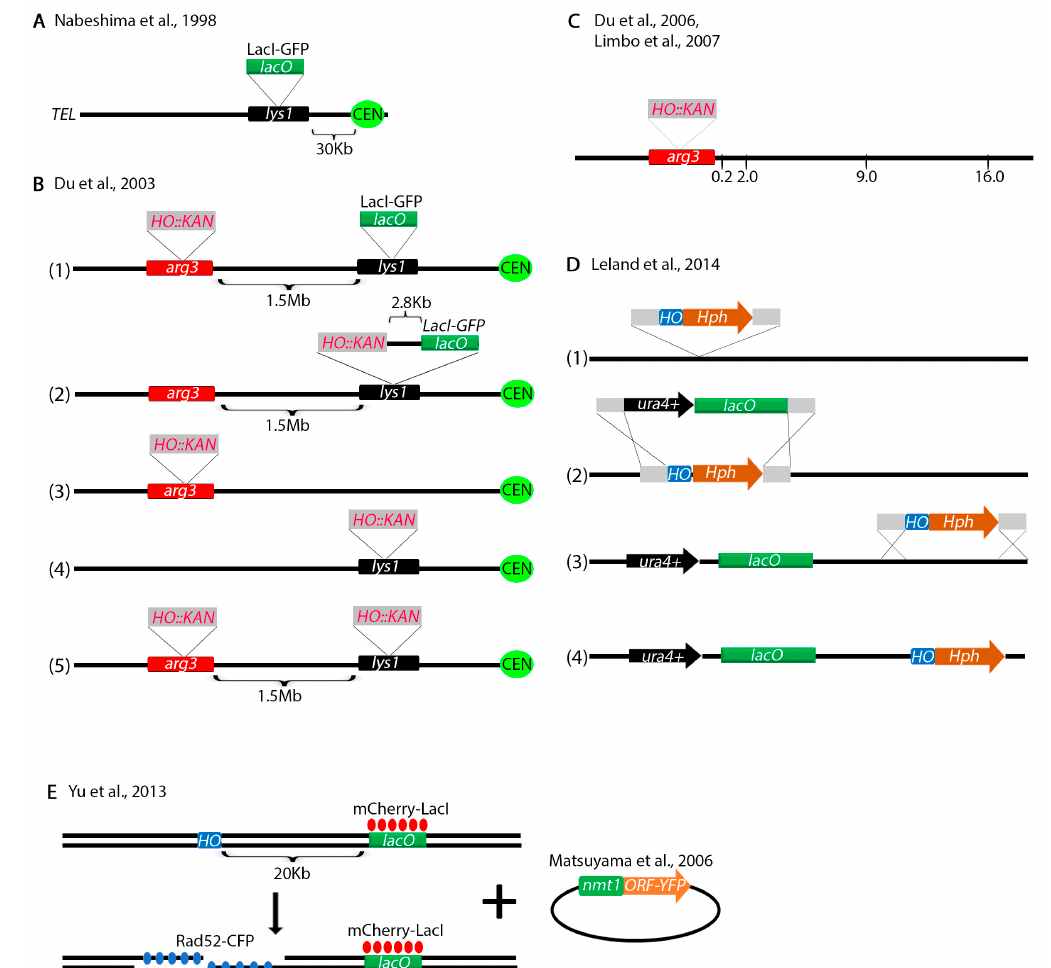
Figure 6. Fluorescence and biochemical assays. ( A ) An assay designed by Nabeshima et al. to study centromere dynamics. A LacO array was placed 30 Kb from the centromere of Ch.I. LacI-GFP binding allows visualization of centromeres. ( B ) Assays developed by Du et al. to study repair of a DSB. (1) The HO endonuclease restriction site marked with KAN was placed 1.5 Mb away from the LacO array at the arg3 + locus. (2) HO::KAN was placed 2.8 Kb from the LacO array. Constructs without a LacO array with the HO restriction site at arg3 + (3), lys1 + (4) or both arg3 + and lys1 + (5) were also engineered. These constructs can be used to study foci of fluorescently tagged DNA damage repair proteins. ( C ) The construct in ( B ) (3) was adapted for Chromatin Immunoprecipitation. PCR primers were engineered at 0.2, 2.0, 9.0 and 16.0 Kb from the break. Upon induction of the break, multiplex PCR can analyze binding of various proteins at all four locations at once. ( D ) An assay to integrate the LacO array and the HO restriction site anywhere in the yeast genome. Please see text for details. ( E ) An assay to study YFP tagged proteins interacting with a DSB. A lacO array that interacts with LacI- mCherry was placed 30 Kb from the HO endonuclease restriction site. The strain also contains Rad52 fused with cyan fluorescent protein (Rad52-CFP). A library of YFP tagged proteins was transformed in the cells and colocalization of all three foci (red, blue, yellow) was monitored. 7. Non-Homologous Repair Non-homologous repair can occur in the absence of homologous regions. Several assays have been designed to test non-homologous repair in S. pombe . In an NHEJ assay designed by Goedecke and colleagues, a plasmid is linearized with various restriction sites to produce non-homologous ends (Figure 7A) [165]. The restriction sites used to generate one of the ends are different from those